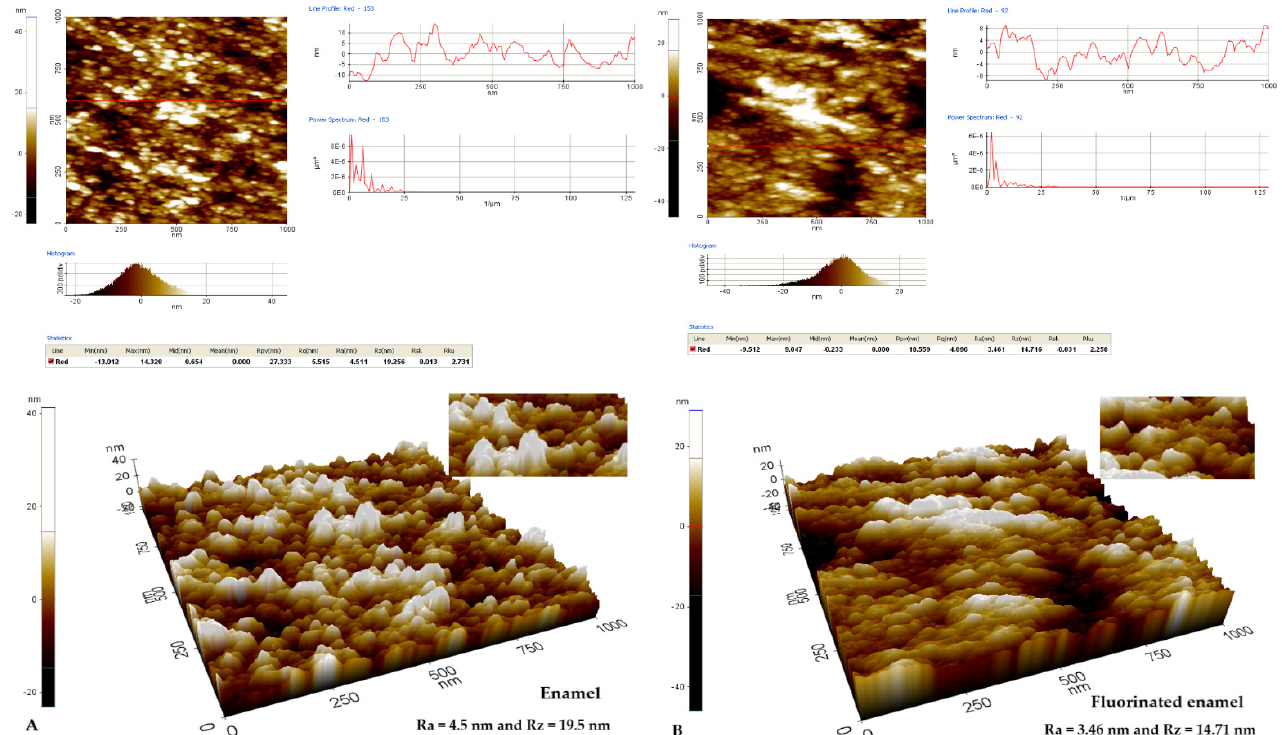
Figure 6. AFM images from the enamel surface layer on the X Scan layer 1 micrometer/Y Scan layer 1 micrometer: ( A ) Two-dimensional and three-dimensional AFM image of the enamel structure in the enamel without fluoridation Ra = 4.5 nm and Rz = 19.256 nm; ( B ) Two-dimensional and three-dimensional AFM image of the enamel structure in the enamel after fluoridation with varnish Ra = 3.46 nm and Rz = 14.71 nm.